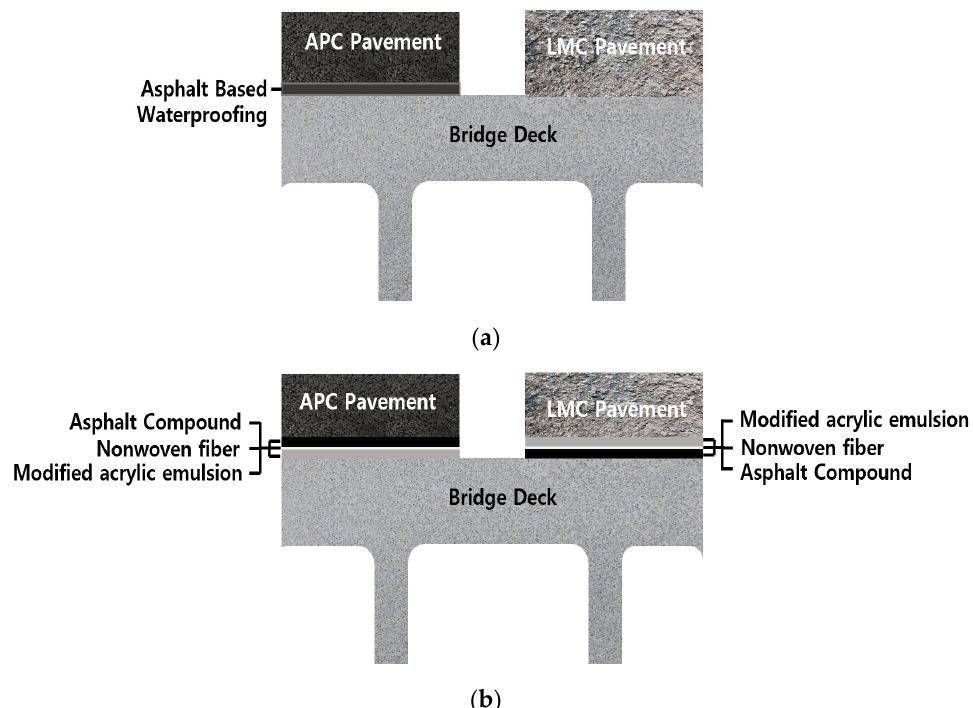
Figure 4. Proposed research scope for improving waterproofing performance of bridge pavements illustrated; ( a ) conventional design of APC and LMC pavement comparison, ( b ) proposed waterproofing method using the double-sided bonding waterproofing sheet concept for both APC and LMC pavements.